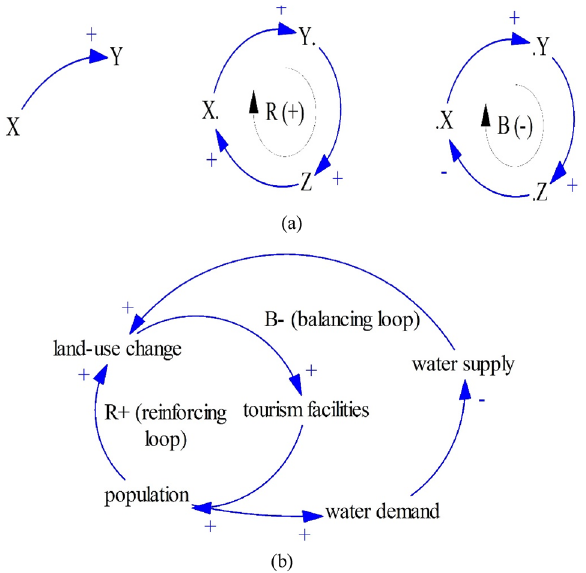
Figure 3. A causal link and feedback loops ( a ), and the Limits to Growth archetype ( b ).